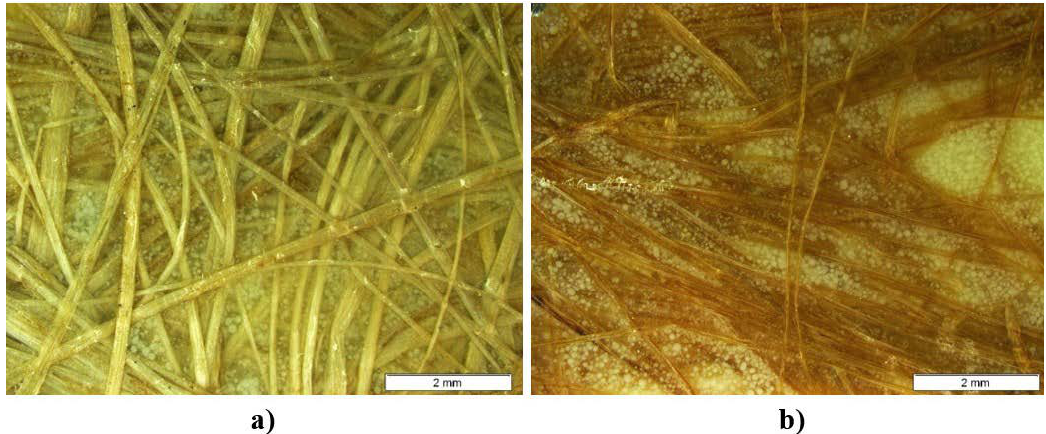
Figure 6: Polypropylene with banana nonwoven and 45% additive: (a) Without treatment (b) With alkali